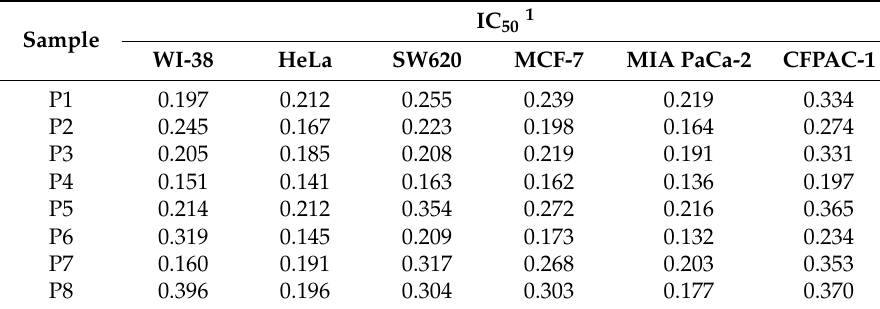
Table 4. The inhibitory concentrations (IC 50 ) of ethanol extracts (PPEs) of pomegranate (Punica granatum L.) peels on normal human fibroblasts (WI38), cervical carcinoma (HeLa), colorectal adenocarcinoma, metastatic (SW620), breast epithelial adenocarcinoma, metastatic (MCF-7), pancreatic carcinoma (MIA PaCa-2) and pancreatic adenocarcinoma, derived from metastatic liver (CFPAC-1).